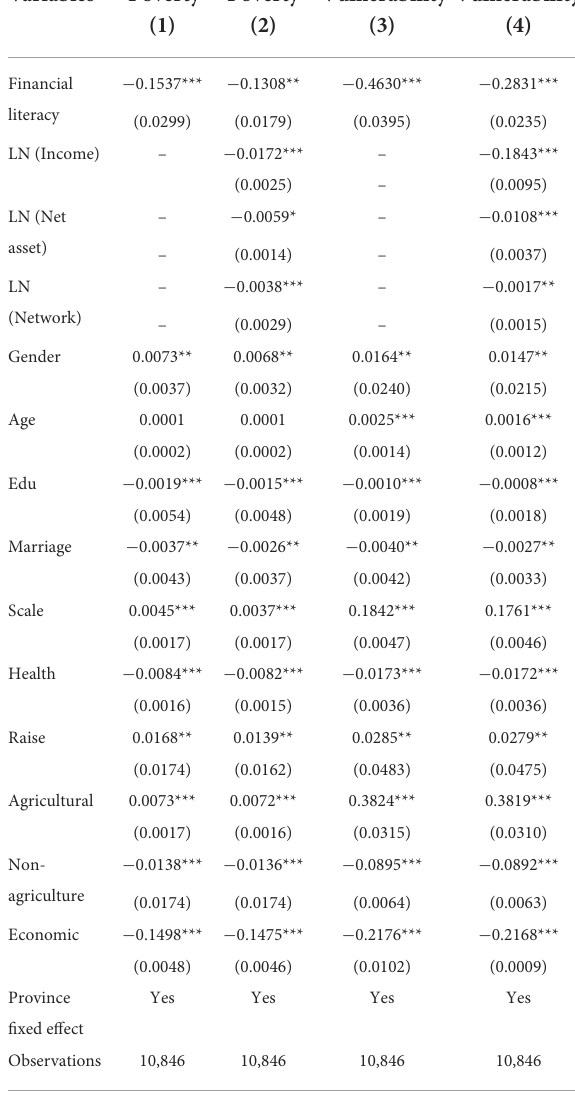
TABLE 4 Benchmark regression: household financial literacy and relative